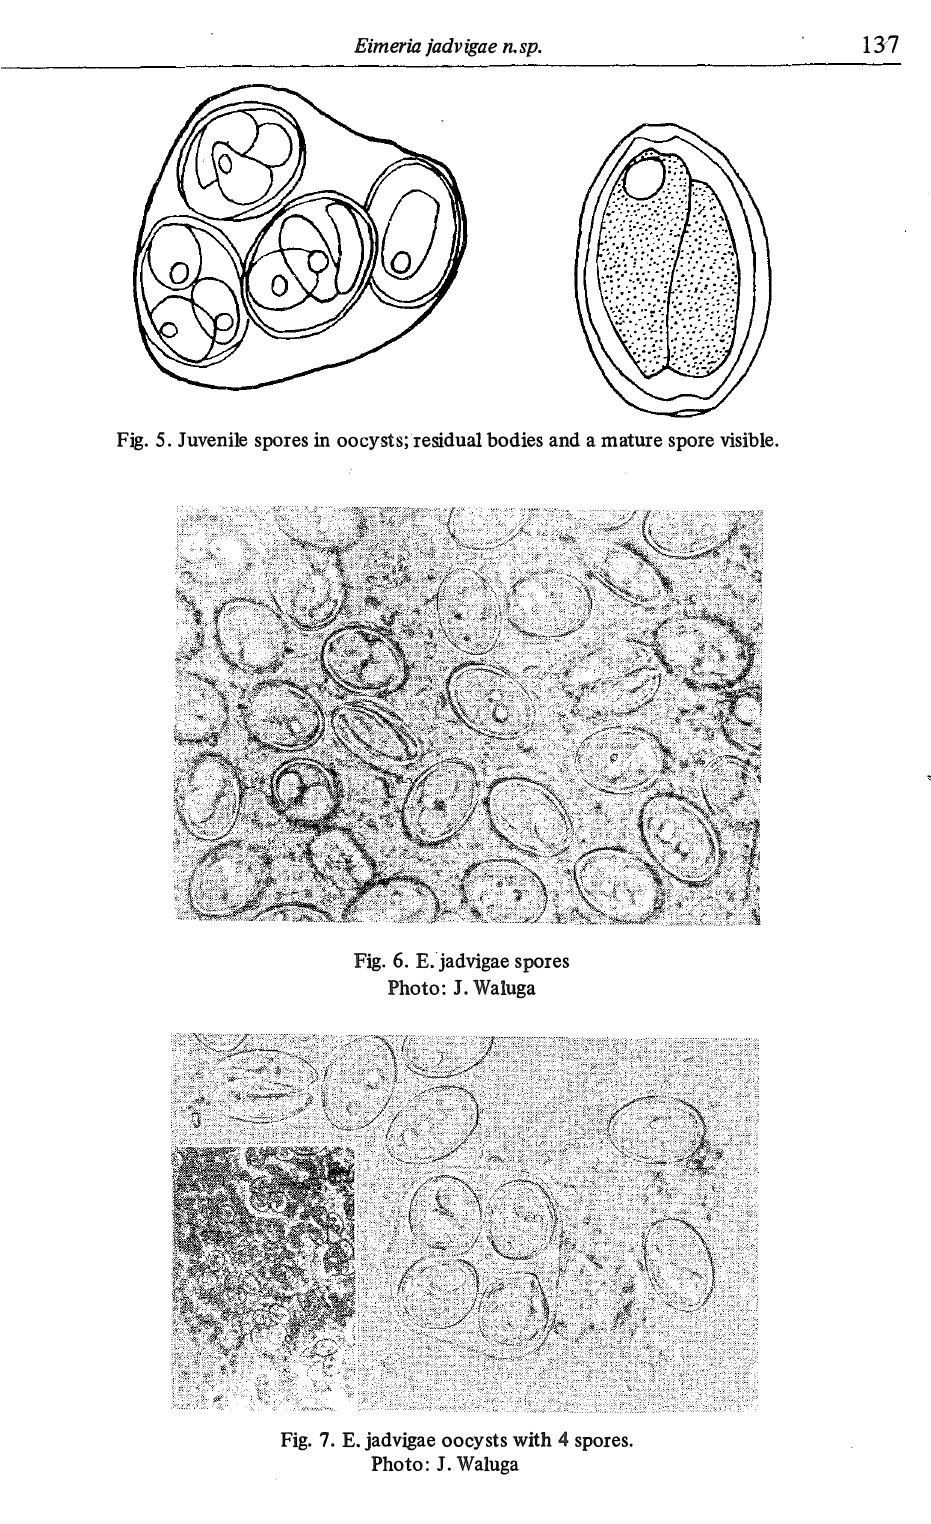
Fig. 7. E. jadvigae oocysts with 4 spores. P ho t o: J. Wal